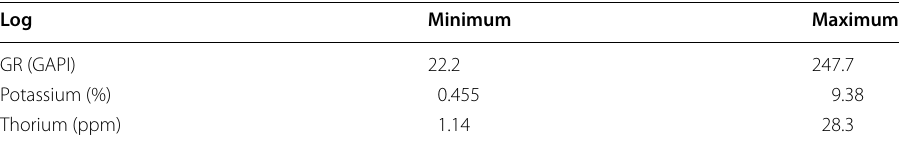
Table 4 The summary of minimum and maximum values of the log readings in the Shuri- jeh Formation